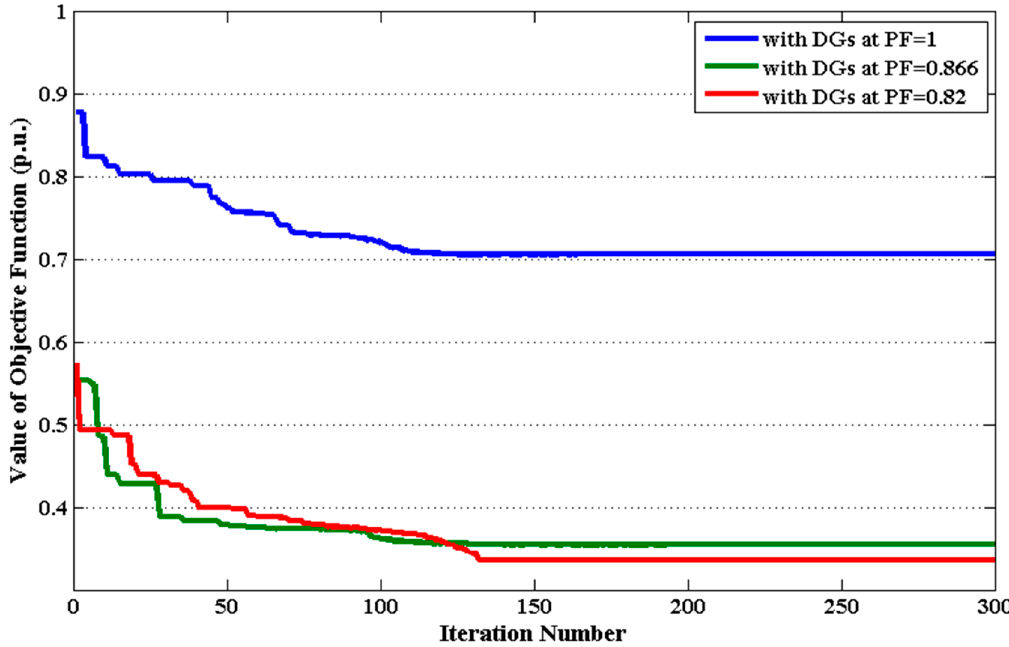
Table 11. Results for the IEEE 118-bus RDS with simultaneous minimization of OF 1 , OF 2 , and OF 3 .